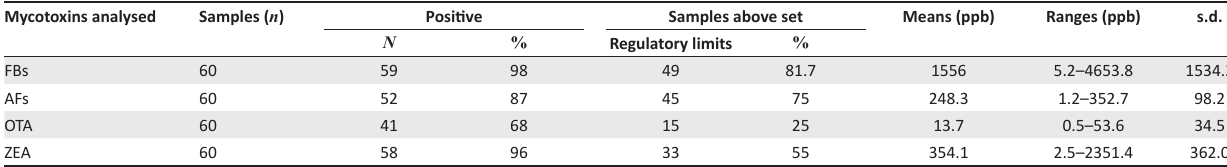
TABLE 1: Mycotoxins distribution in selected dog food obtained from retail outlets in South Africa. Mycotoxins